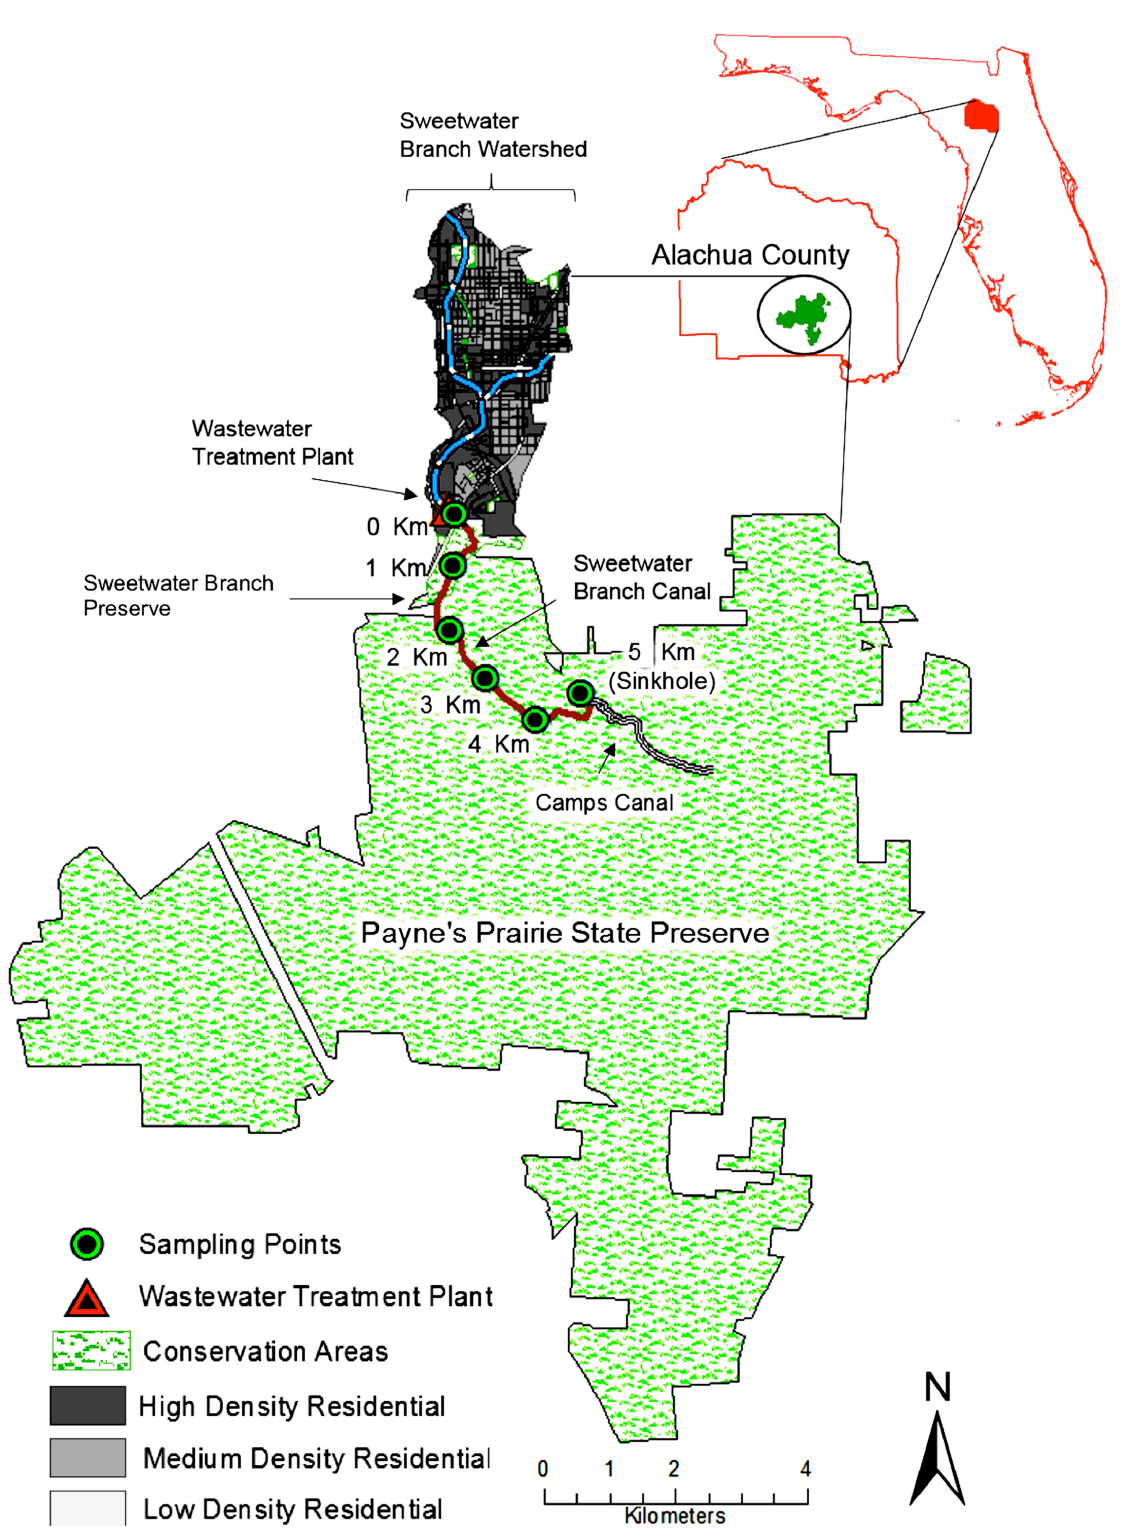
Fig 1. Water and sediment sampling points along Sweetwater branch